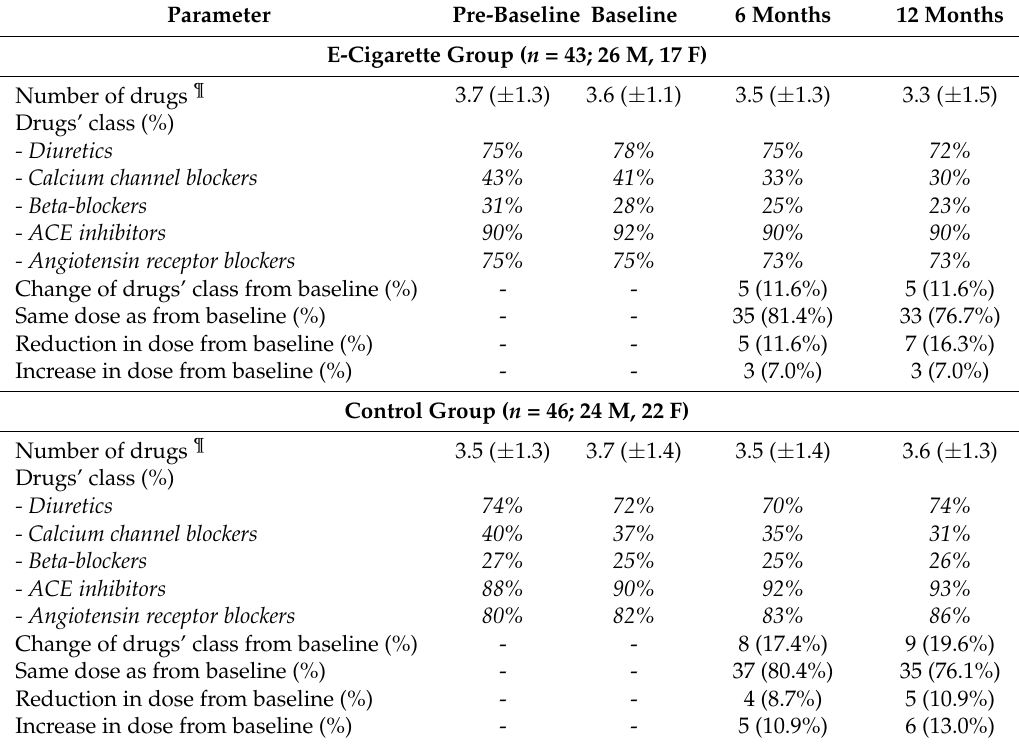
Table 5. Details of anti-hypertensive medications use at baseline, 6- and 12-months for both study